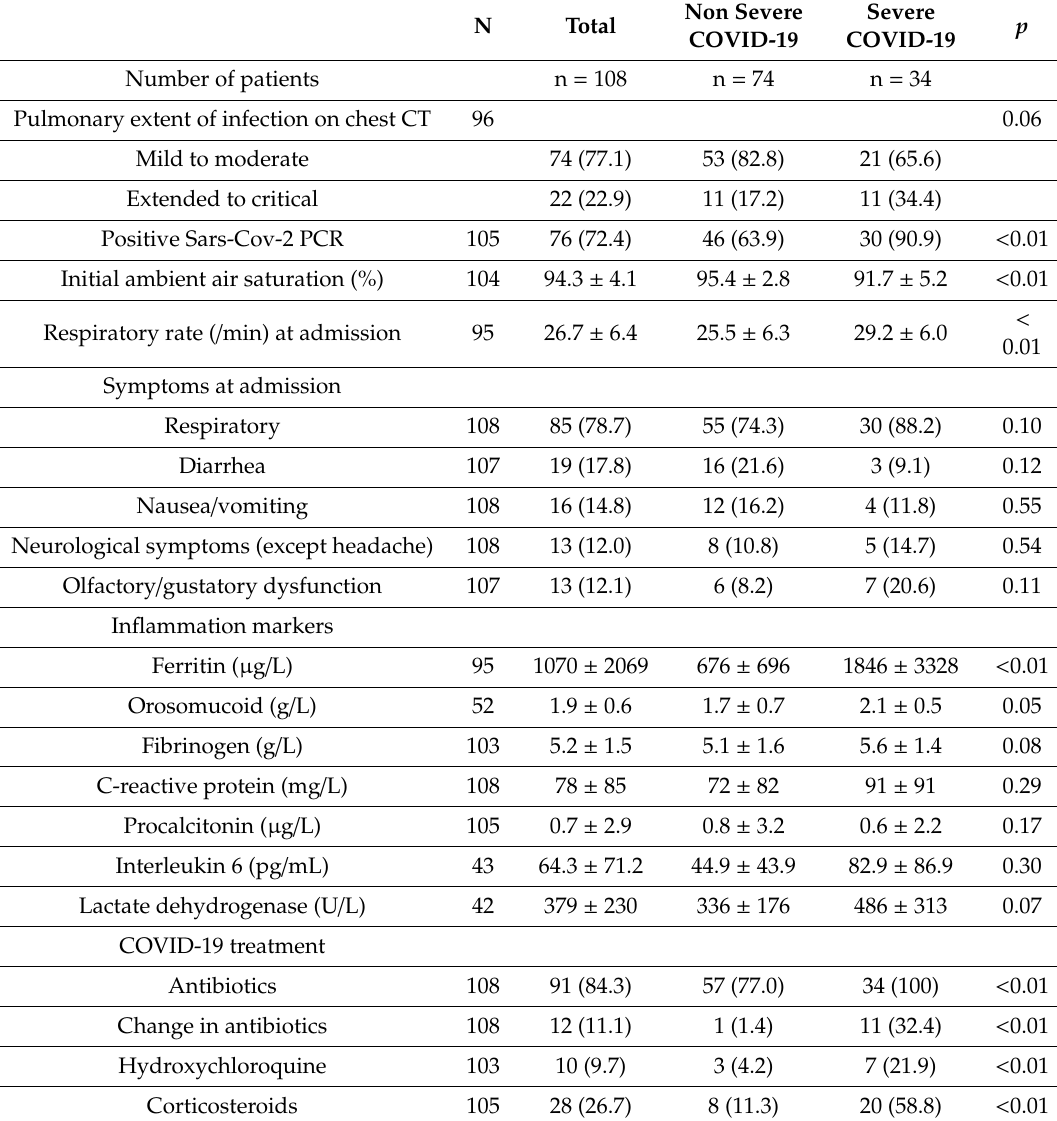
Table 2. Clinical, biological, and radiological data at admission and COVID-19